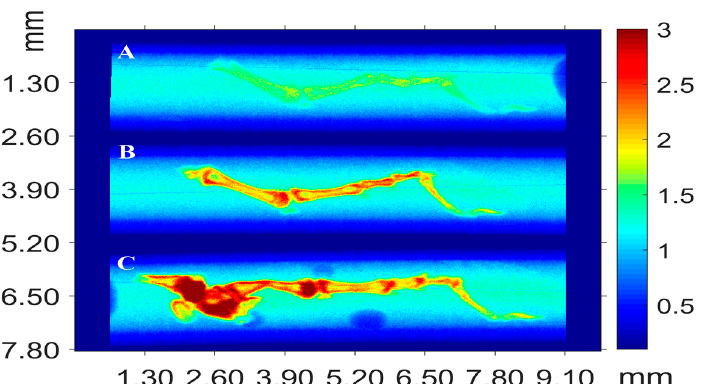
Figure 3. X-ray µ CT projections of the thick-toed gecko phalangeal bones. ( A ) Flight group gecko toe, average absorption for the sample—1.429. ( B ) Delayed synchronous control group gecko toe, average absorption for the sample—1.700. ( C ) Basal control group gecko toe, average absorption for the sample—3.136. Extracellular matrix density is colored in the right scale: the densest areas are red-orange. In the toe of gecko exposed to weightlessness twofold low density in comparison with the laboratory control is